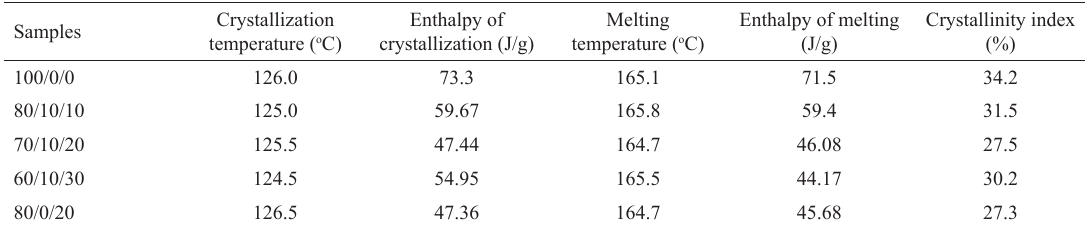
Table 2: Thermal properties of the analyzed formulations.